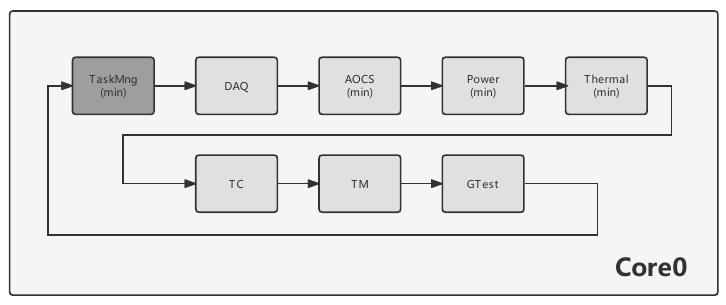
Figure 5. Low-power